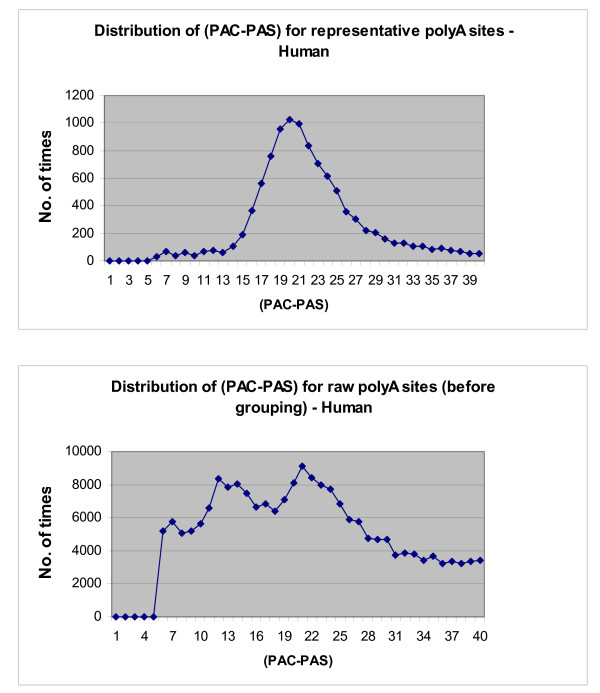
Distribution of spacing between polyA cleavage (PAC) site and polyA signal (PAS) in human transcript patterns from AltTrans. The bottom inset uses the data set of heterogeneous polyA sites; the top inset uses the data set of representative polyA sites (Nearby heterogeneous polyA sites are grouped and a representative polyA site is chosen – see text for methods).